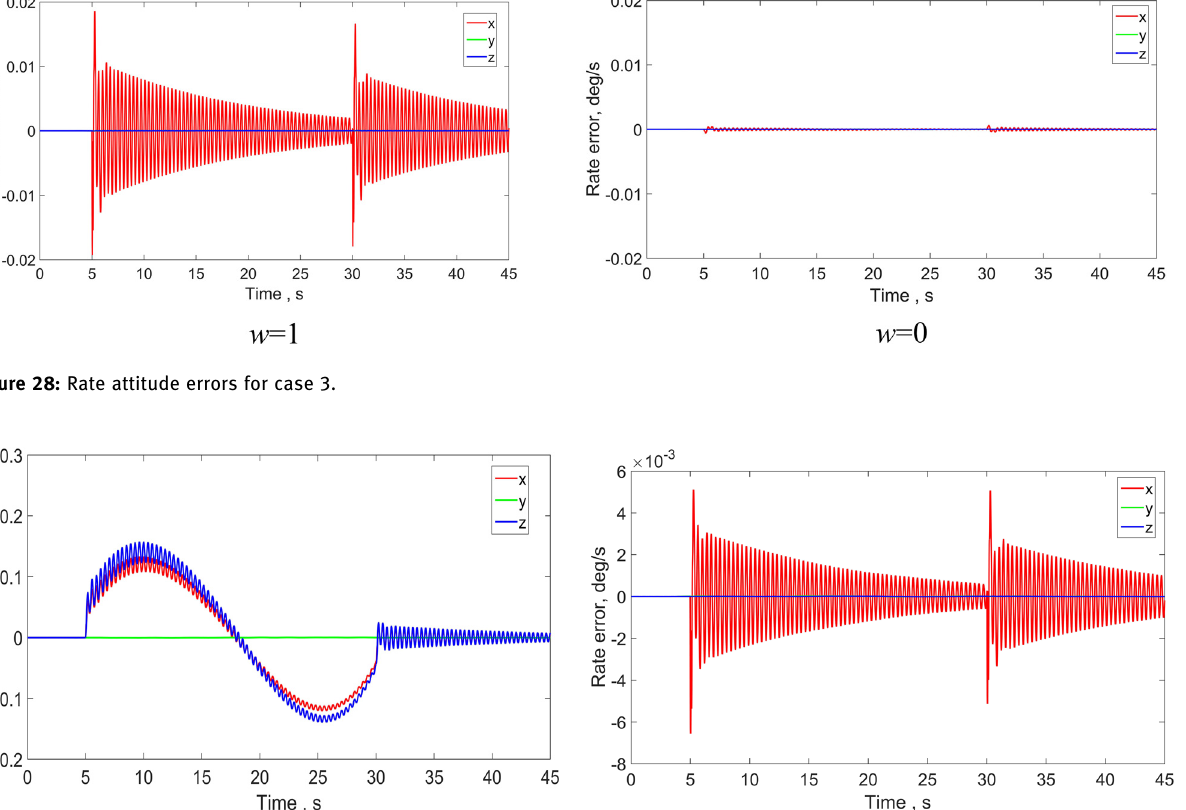
Figure 31: Rate attitude errors for case 3 ( w = 0.3 ) .